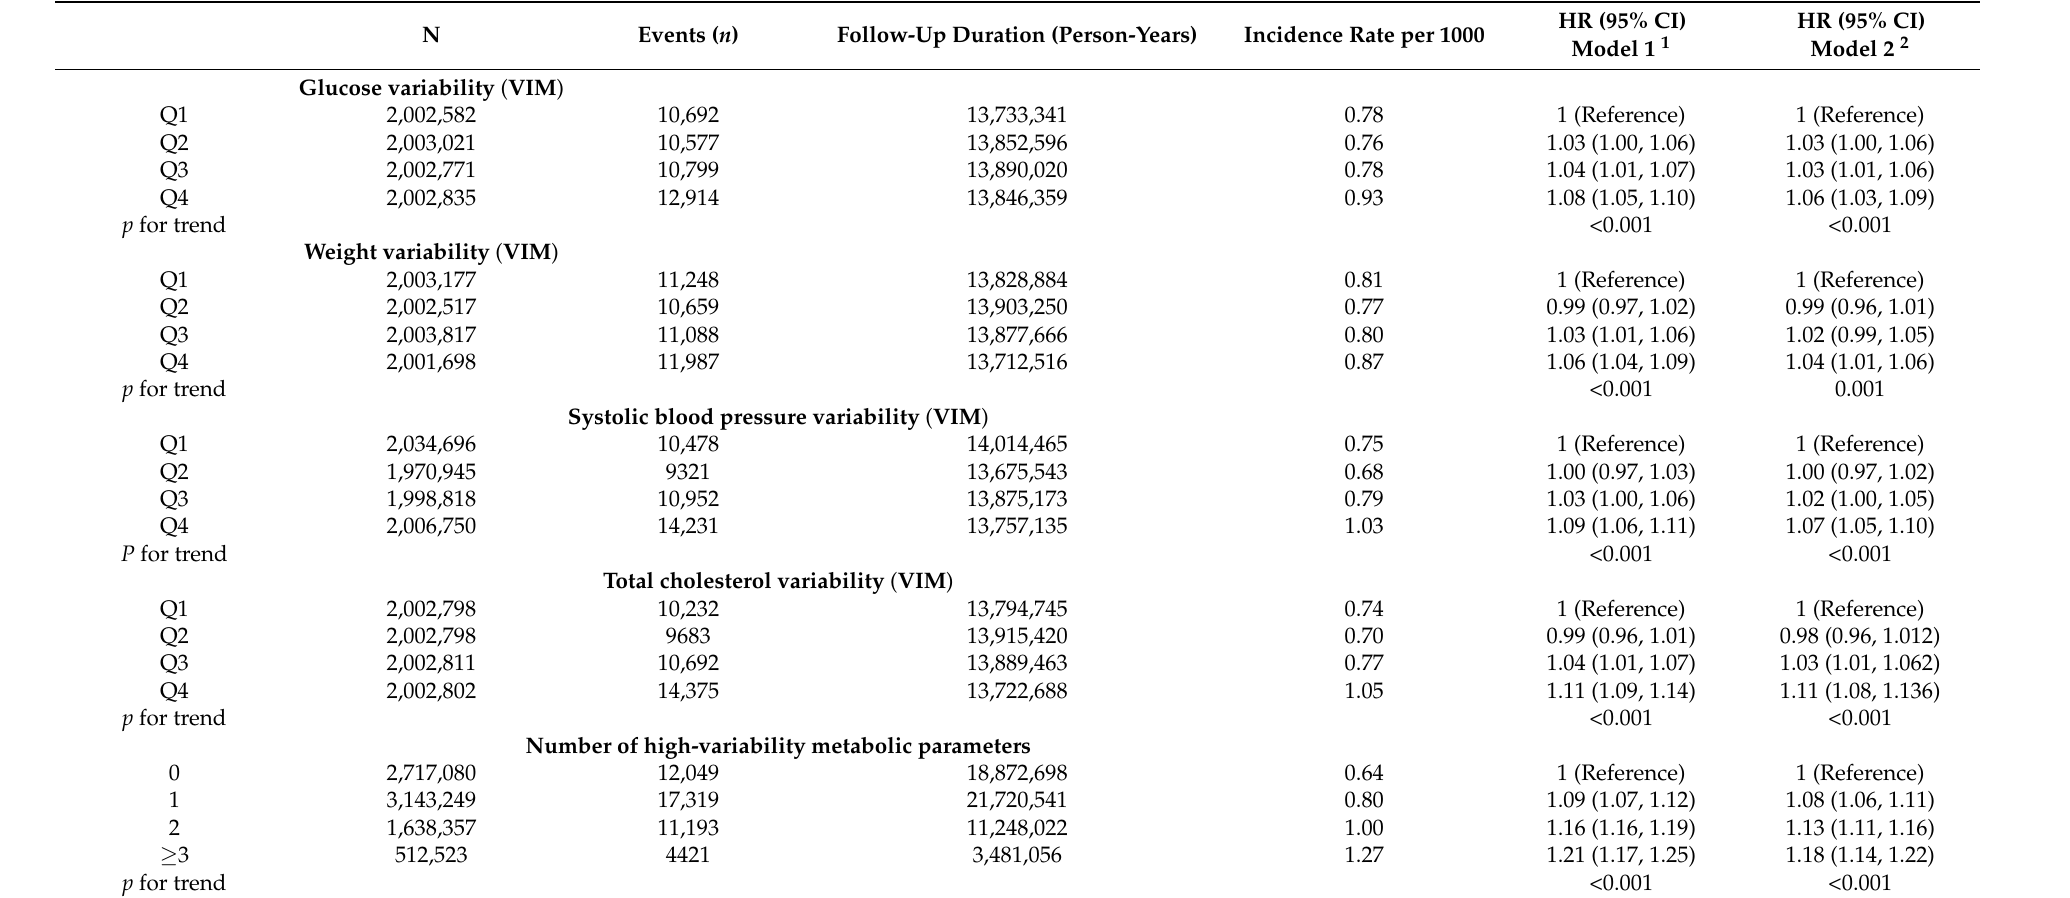
Table 2. Lung cancer risk by quartiles of metabolic parameter variability and number of high-variability metabolic